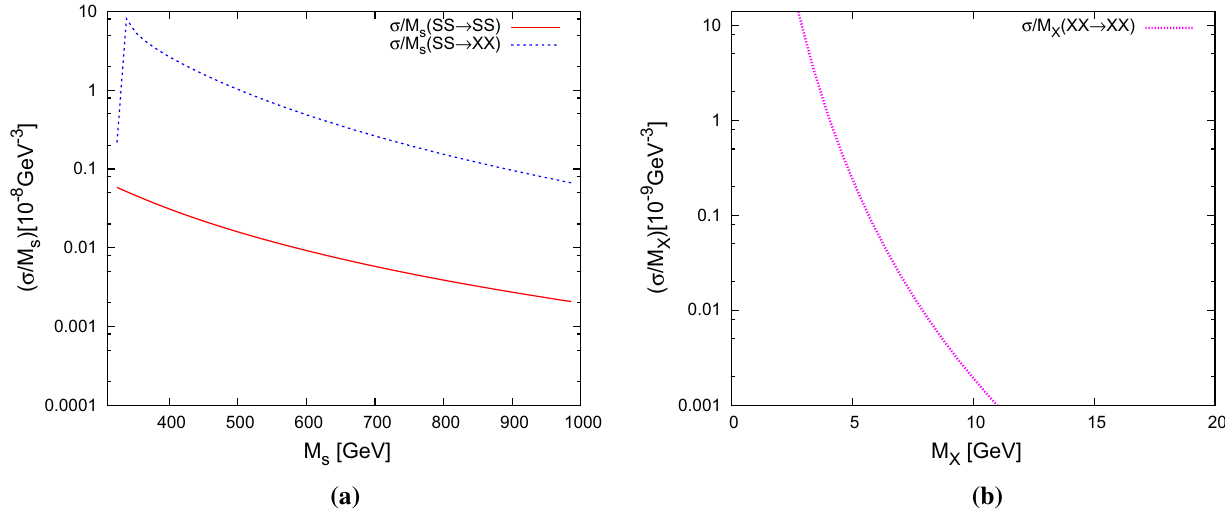
Fig. 10 a The scalar self-interaction cross section as a function of the scalar DM mass. We set M χ = 100 GeV and g = 0 . 5 λ φ s = 2 and λ s = 2. b The fermionic self-interaction cross section as a function of the fermion DM mass. The input parameters are similar to ( a ) except M s = 500 GeV